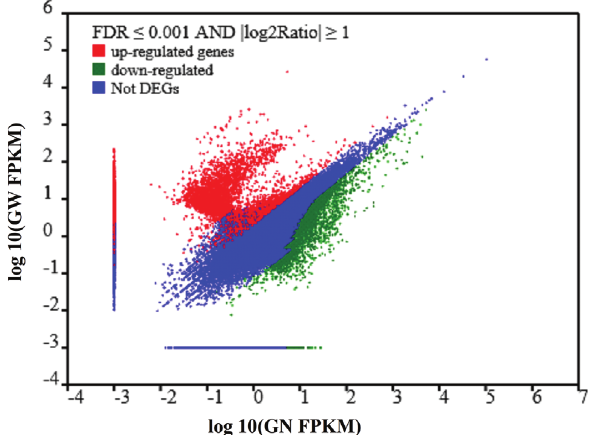
Figure 3 - Comparative analysis of the gene expression levels for two transcript libraries between normal (GN) and WSSV-challenged (GW) crayfish gills. Red dots represent transcripts significantly up-regulated in GW, while green dots represent significantly down-regulated transcripts. The parameters “FDR (cid:3) 0.001’’ and “| log2 Ratio| (cid:4) 1’’ were used as the threshold to judge the significance of gene expression